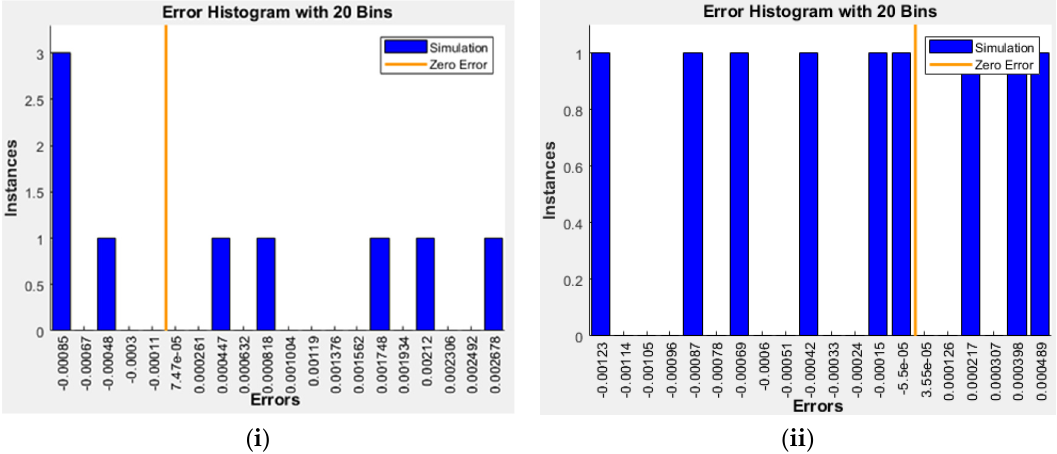
Figure 6. Regression of simulated data for ( i ) AN7-A, ( ii ) AN7-B.